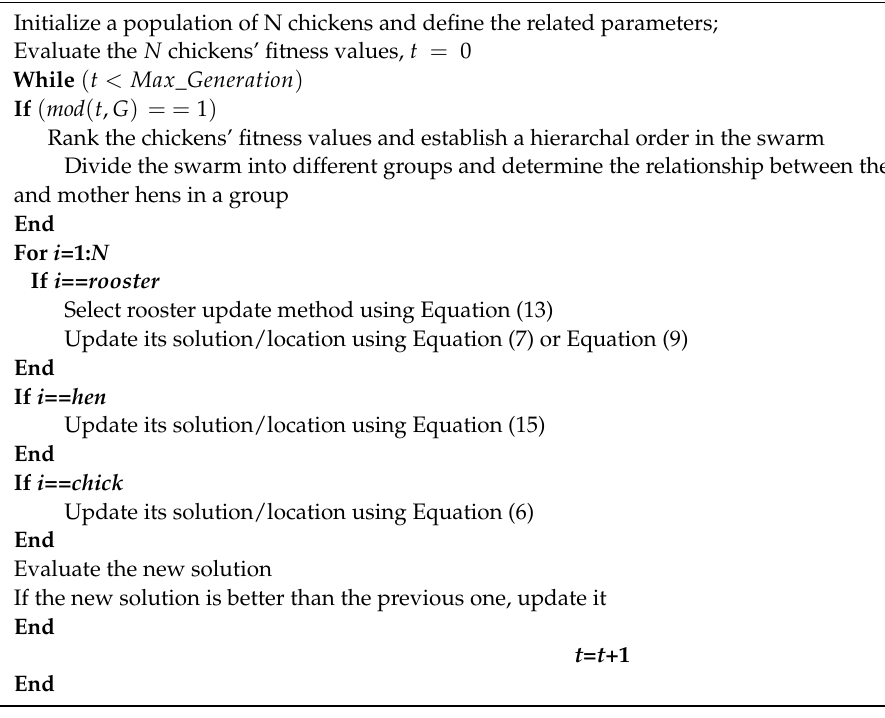
Algorithm 1: Pseudocode for the PDCSO